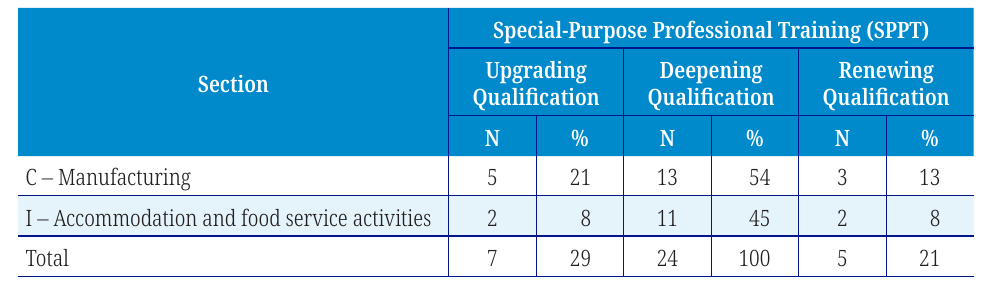
Table 3. Employees’ special-purpose professional